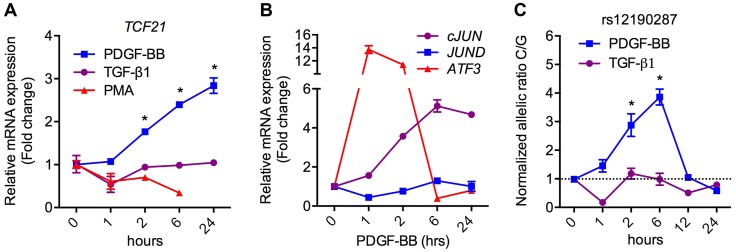
PDGFRβ is upstream of TCF21 at rs12190287 in HCASMC.(a) TaqMan based qRT-PCR results showing relative mRNA expression levels of total TCF21 in heterozygous HCASMC treated with TGF-β1, PDGF-BB or PMA for indicated times. Expression levels were normalized to 18S and expressed as fold change from 0 h. *P<0.0001 versus 0 h. (b) TaqMan qRT-PCR expression results of c-JUN, JUND, and ATF3 in heterozygous HCASMC treated TGF-β1 or PDGF-BB for the indicated times. (c) Allele-specific TaqMan qRT-PCR based expression of TCF21 at rs12190287 shown as normalized allelic ratio C/G in heterozygous HCASMC treated with either TGF-β1 or PDGF-BB for the indicated times. *P<0.01 versus 0 h. Values are mean ± SD of triplicates. Similar results were observed from three independent experiments.